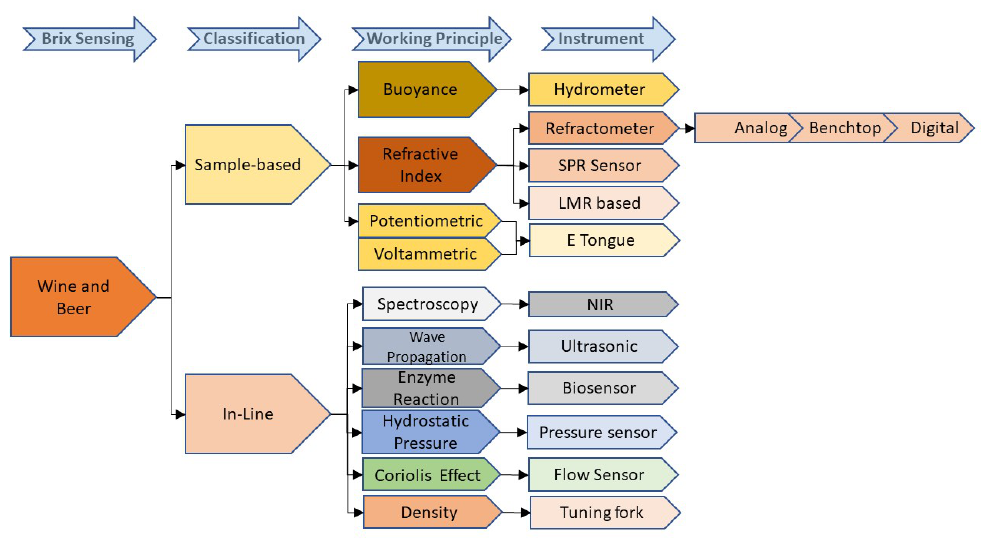
Figure 8. Brix measurement methods for wine and